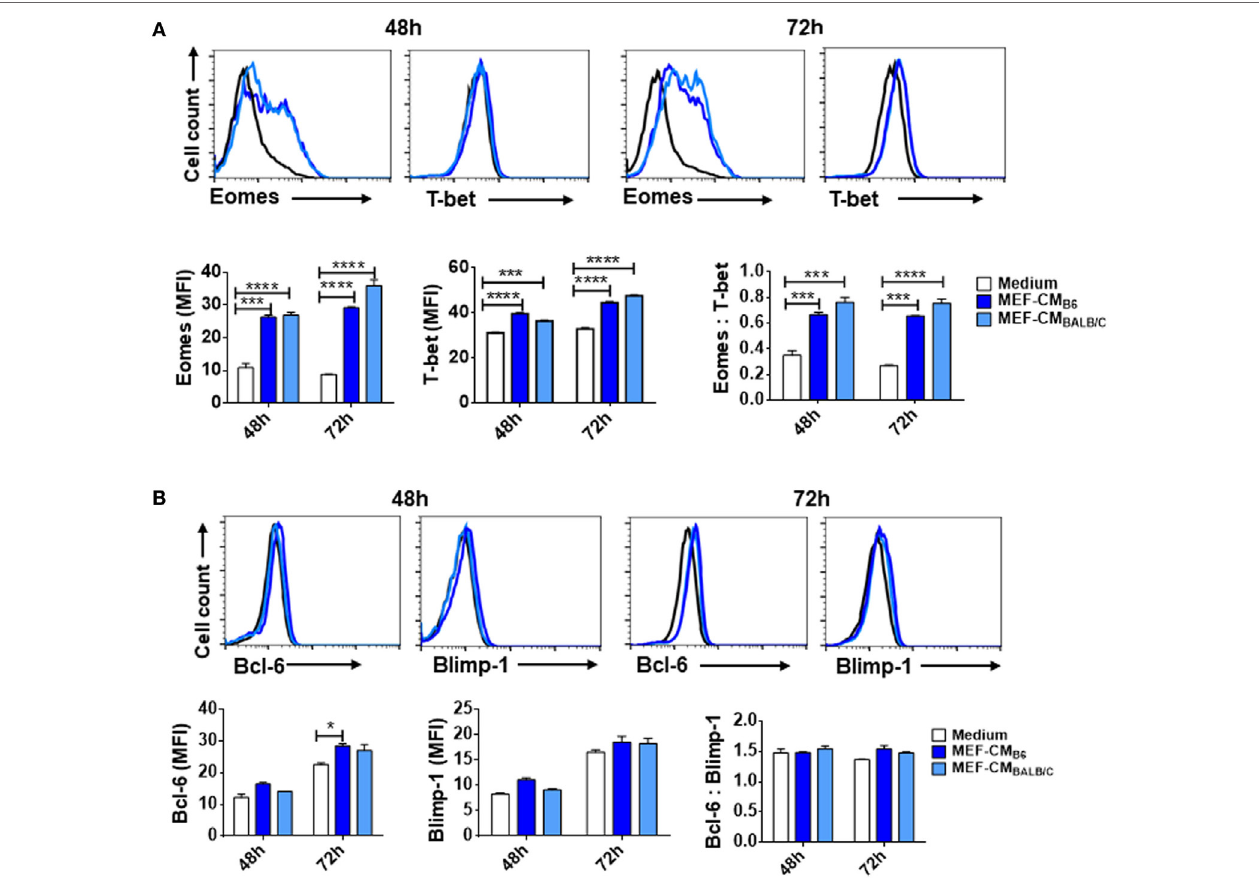
FigUre 3 | Mouse embryonic fibroblast-conditioned medium (MEF-CM) strongly induces eomesodermin expression. OT-1 CD8 + T cells were stimulated in the presence or absence of MEF-CM (50%, v/v). (a,B) T-bet, Eomes, Bcl-6, and Blimp-1 were examined after 48 and 72 h stimulation using intracellular fluorescence- activated cell sorting analysis. Histograms represented the mean fluorescence intensity (MFI) values of the transcription factors (left and middle), and the ratio of MFI for Eomes relative to T-bet or Bcl-6 to Blimp-1 (right). Data represent at least three independent experiments with similar results. Statistical significance was analyzed by two-way ANOVA with Bonferroni’s multiple comparison test (* P ≤ 0.05; *** P ≤ 0.001; **** P ≤